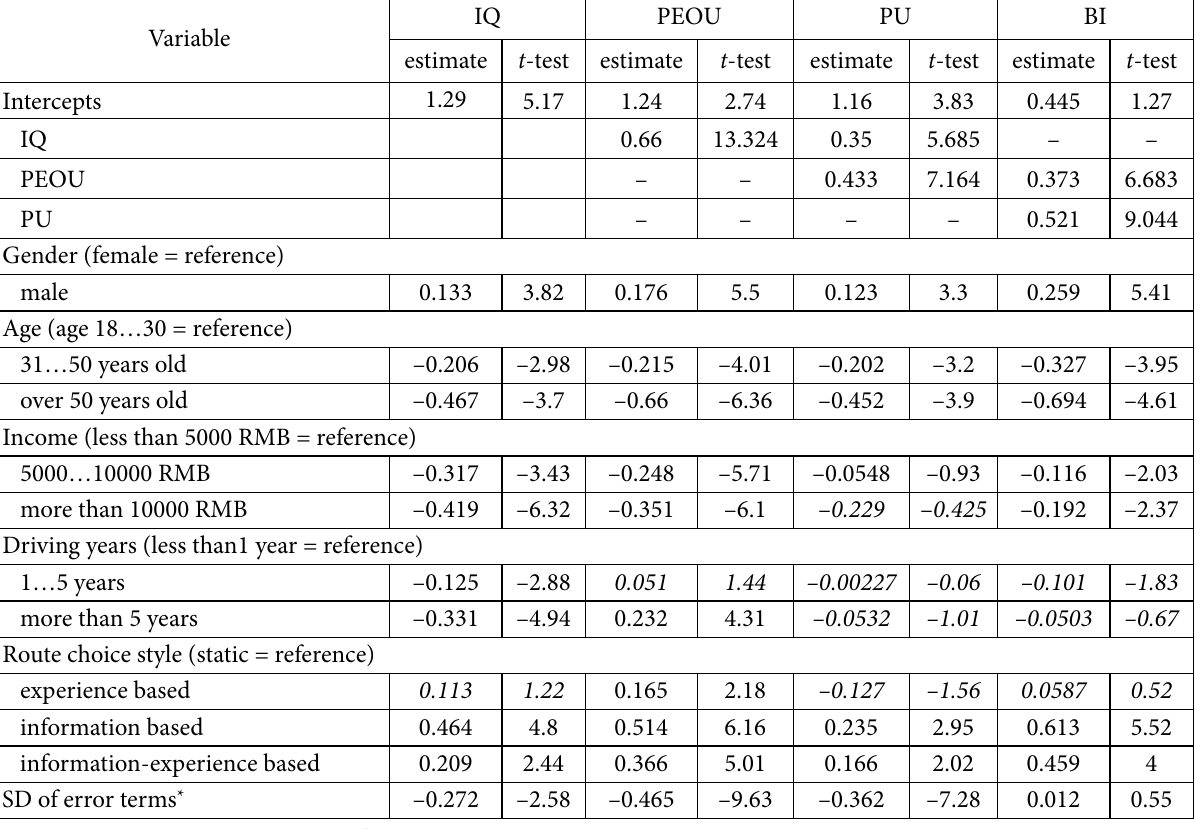
Table 9. Results of the structural part of the latent variable model (based on